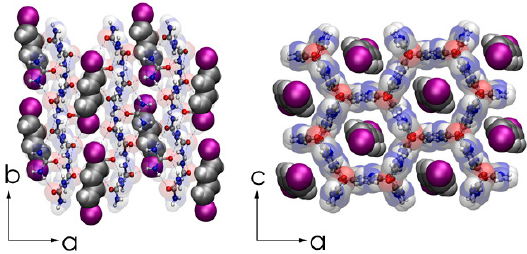
Figure 9. Representations of the commensurate, fully ‐ ordered single ‐ crystal DIBD–urea inclusion compound (UIC) complex as obtained by X ‐ ray diffraction at 90 K viewed along the c (left panel) and b (right panel) crystal axes. Redrawn from structure Crystallographic Information File, cif of [85]. The DIBD–urea complex used in this study is unusual in that it is a commensurate structure, in contrast to most other UICs such as those formed by n ‐ alkanes. DIBD–urea crystals have Raman features due to DIBD at 1600 and 1250 cm − 1 . The strong tetragonal urea feature at 1010 cm − 1 is shifted to 1022 cm − 1 , the value observed for hexagonal urea. Irradiation with ultraviolet (UV) light results in new Raman modes near 1509 and 1125 cm − 1 [86] (Figure 10a), nearly identical to spectra of